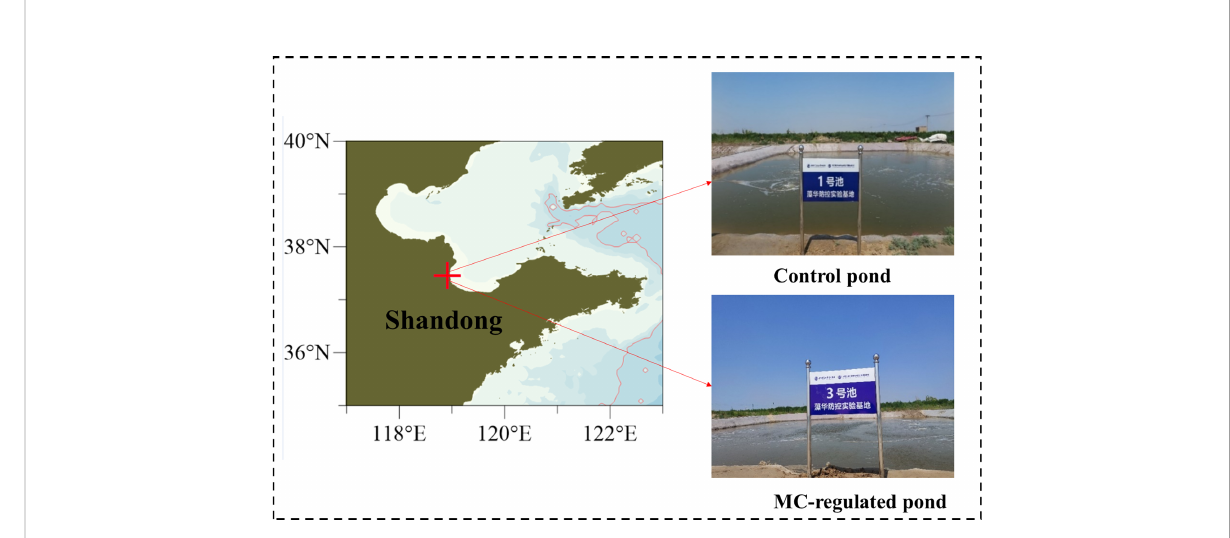
FIGURE 1 The locations of mariculture shrimp ponds in the Laizhou